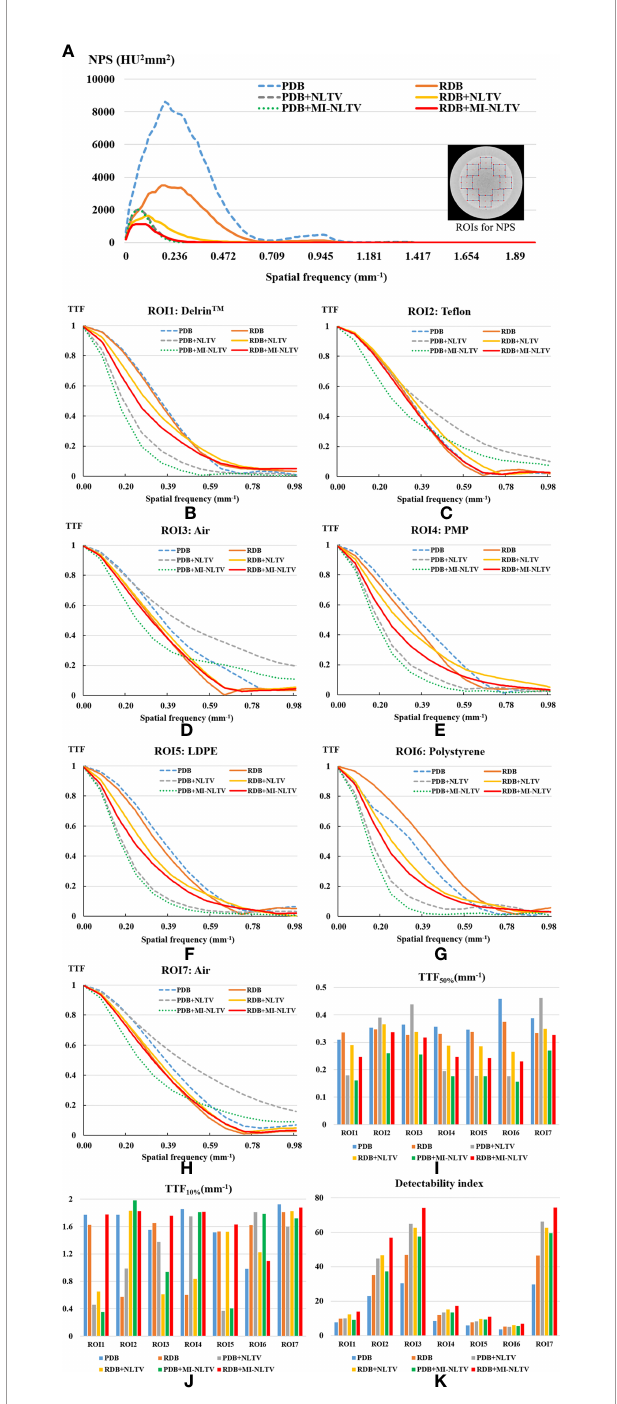
FIGURE 3 | Task-based image quality assessment for PDB, RDB, PDB+NLTV, RDB+NLTV, PDB+MI-NLTV, and RDB+MI-NLTV. (A) Noise power spectrum (NPS) for evaluating the noise texture and magnitude. (B – H) The task-based transfer function (TTF) curves calculated by selecting a circular ROI around each insert among seven different density targets. (I) TTF 50% values and (J) TTF 10% values for assessing the spatial resolution. (K) The detectability index based on NPS and TTF for estimating the ability to detect some regions.